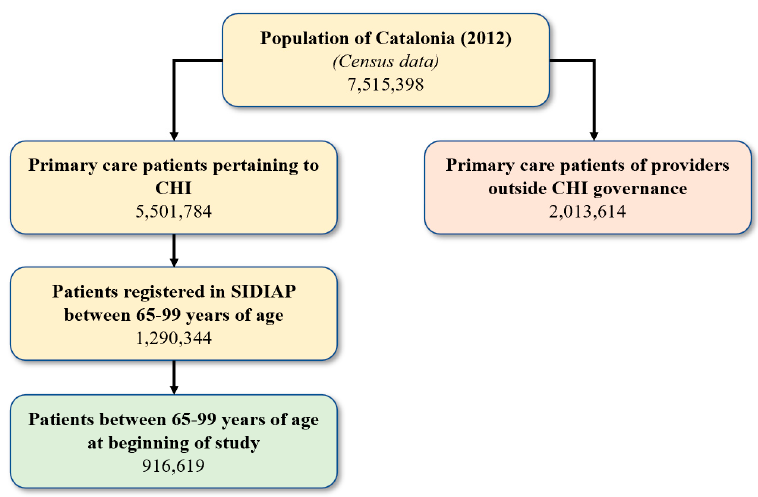
Figure 1. Estimated population study according to selection criteria.